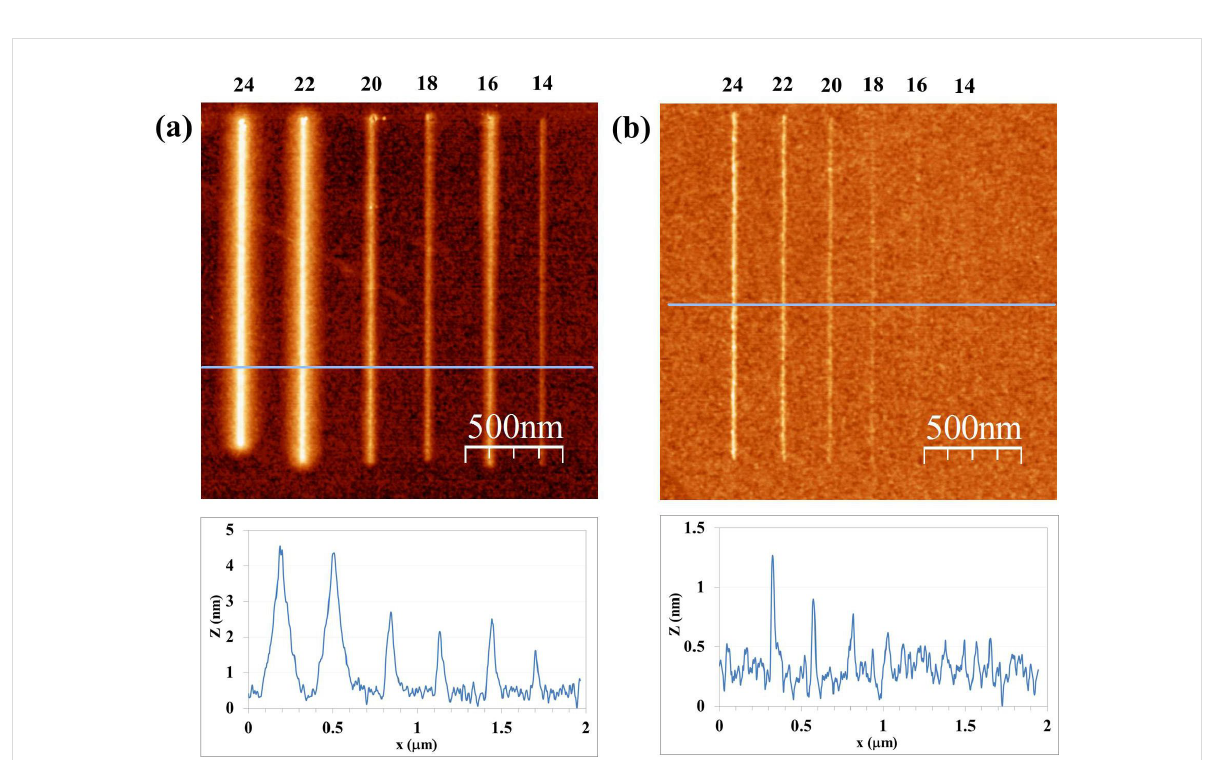
Figure 3: Results of LAO-AFM on Si with CNF (a) and Si (b) probes as a function of the bias voltage (in V). Writing speed is 1 μ m/s, RH is